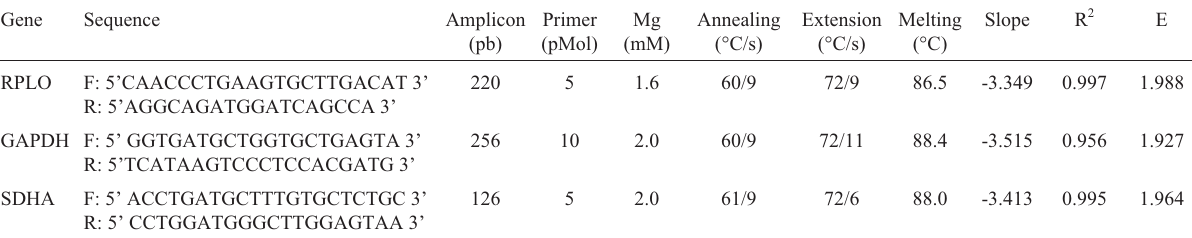
Table 1 - PCR conditions and slope, correlation coefficient (R 2 ) and efficiency values (E) for each reference gene. Gene